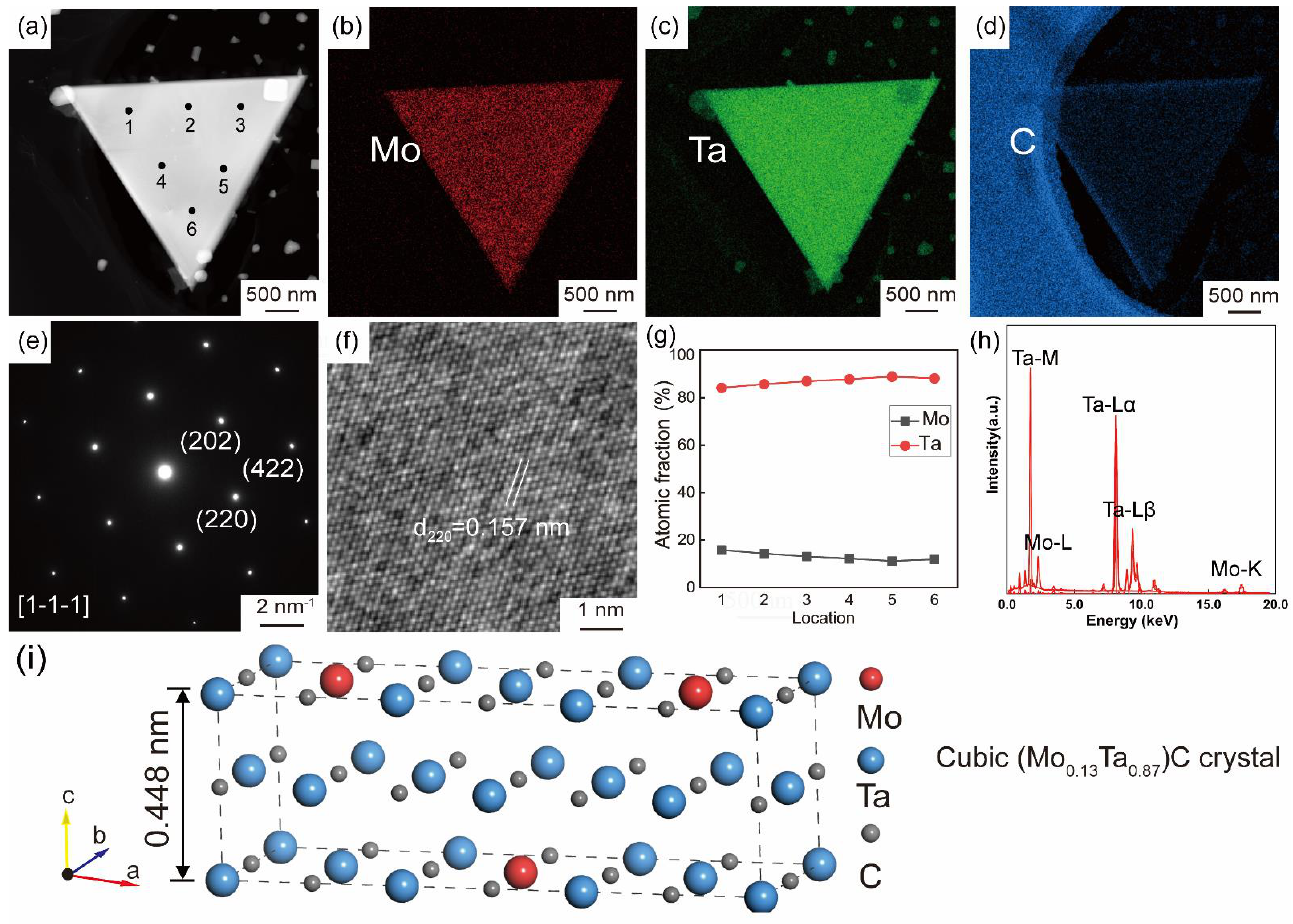
Figure 3. TEM images of triangular MTC crystal ( a ) and corresponding EDS elemental mapping of Mo ( b ), Ta ( c ), and C ( d ). SAED pattern along [1 – 1 – 1] zone axis ( e ) and HRTEM image of a triangular crystal ( f ). Atomic fraction of Mo and Ta in the triangular crystal of ( a ). ( g ) Based on EDS spectrum ( h ). ( i ) Crystallographic structure of cubic (Mo 0.13 Ta 0.87 )C.